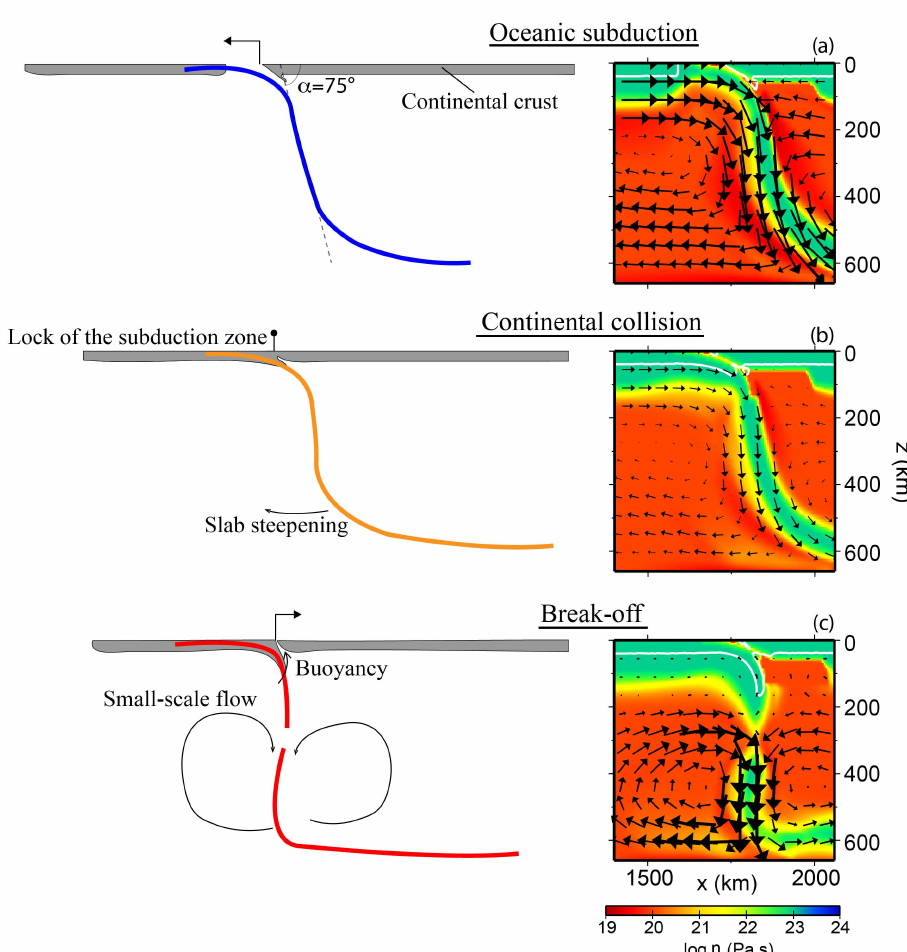
Fig. 7. Schematic evolution of the continental models C1 (left column) and its viscosity plot in the column on the right (the continental material is outlined in white): (a) during oceanic subduction the trench retreats; (b) the continental collision causes the lock of the subduction zone and a consequent steepening of the slab; (c) the formation of small-scale convection cells and the exhumation of the buoyant continental material cause the advance of the trench after continental collision and during the slab